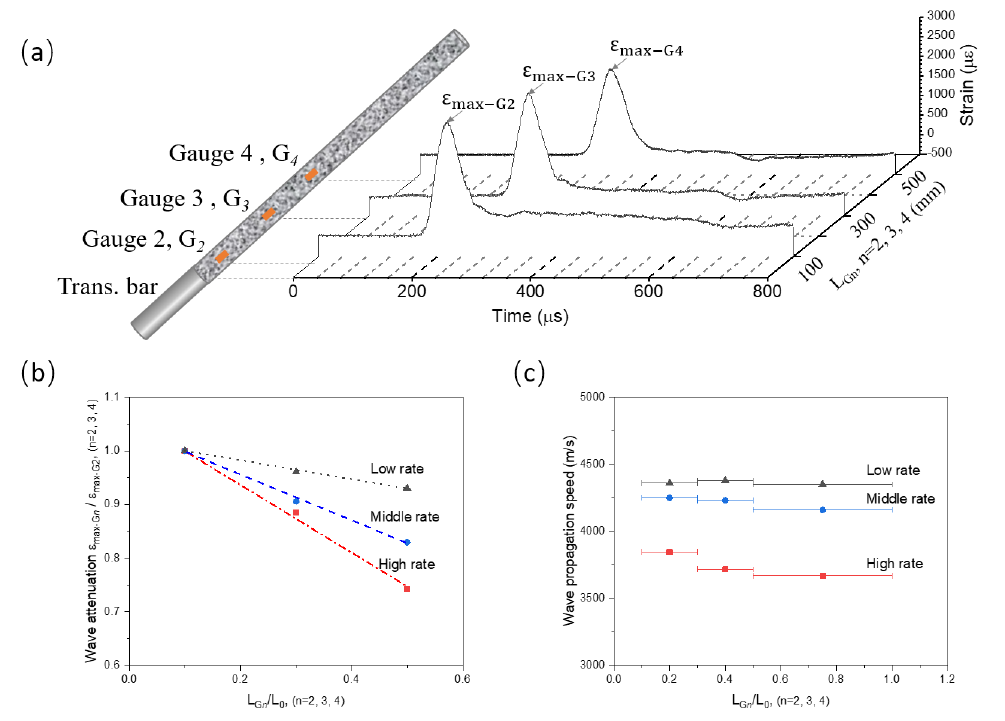
Figure 8. Propagation of stress wave in concrete bar ( a ) is identified by the strain data measured by Gauges 2, 3, and 4. The attenuation ( b ) and propagating speed of ( c ) stress wave are compared with loading rates: Low rate (7 m/s), middle rate (18 m/s), and high rate (33 m/s). L Gn ( n = 2,3,4 ) denotes the relative location of three gauges ( G 2 , G 3 , and G 4 ). L 0 represents the length of concrete